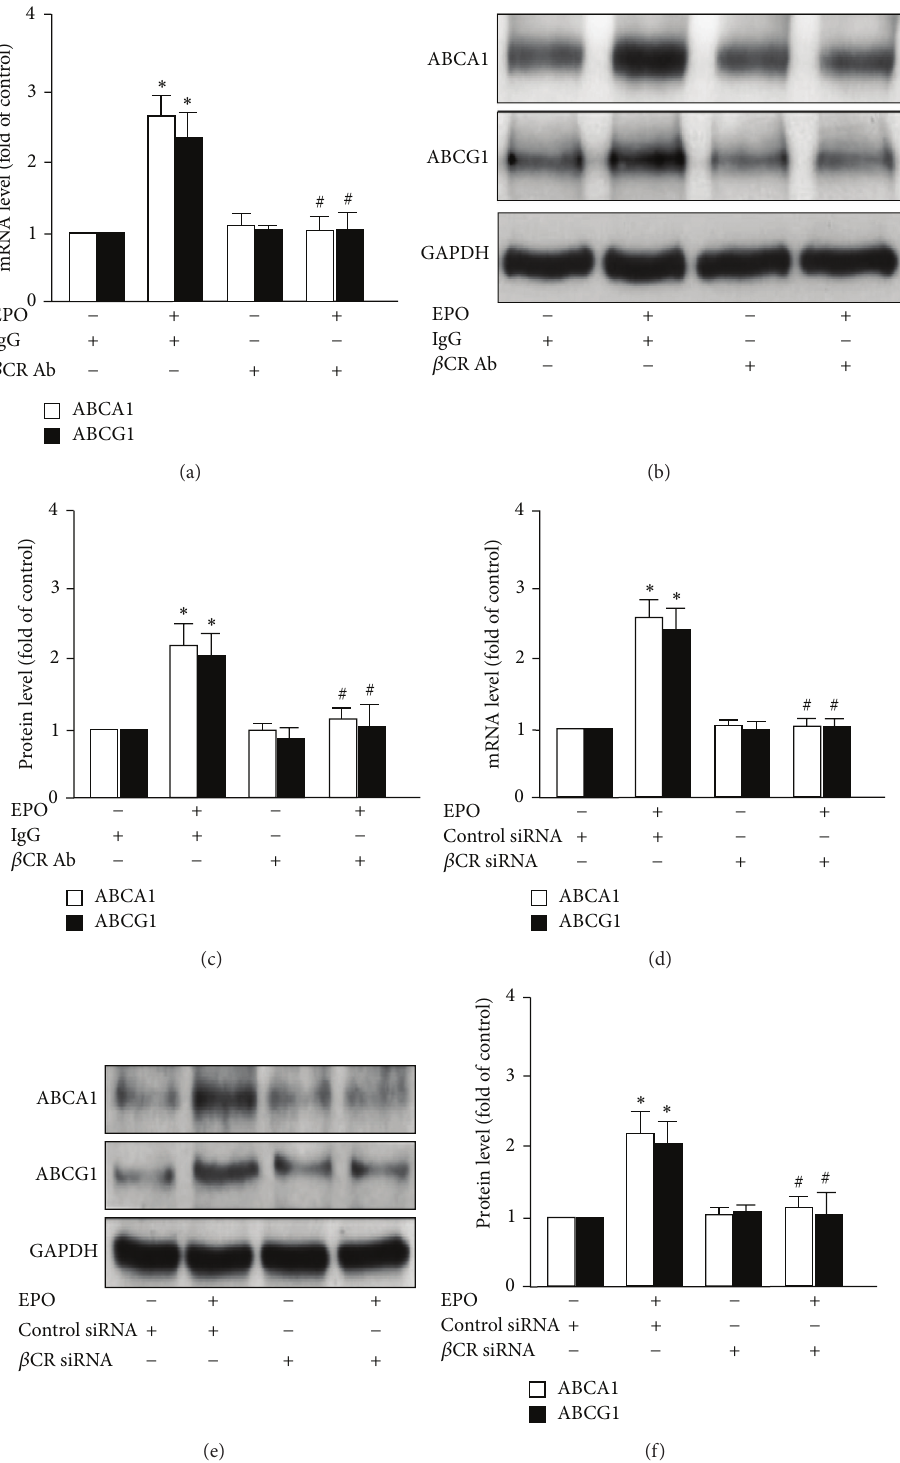
Figure 7: Blockage of 𝛽 CR activation ablates EPO-induced upregulation of ABCA1 and ABCG1 transporters in macrophages. Bone-marrow- derived macrophages were pretreated with IgG (200ng/mL) or 𝛽 CR neutralizing Ab (200 ng/mL) for 2 h (b) transfection with control siRNA (50 nmole/L) or 𝛽 CR siRNA (50nmole/L) for 24h and then treated with EPO (5 U/mL) for 12h or 24 h. Cell were lyzed and lyates subjected to RT-PCRand western blot analysis for mRNAor protein expression of ABCA1, ABCG1, and GAPDH. Data is mean ± SEM from5 independent experiments. ∗ 𝑃 < 0.05 versus vehicle-treated group and # 𝑃 < 0.05 versus EPO-treated